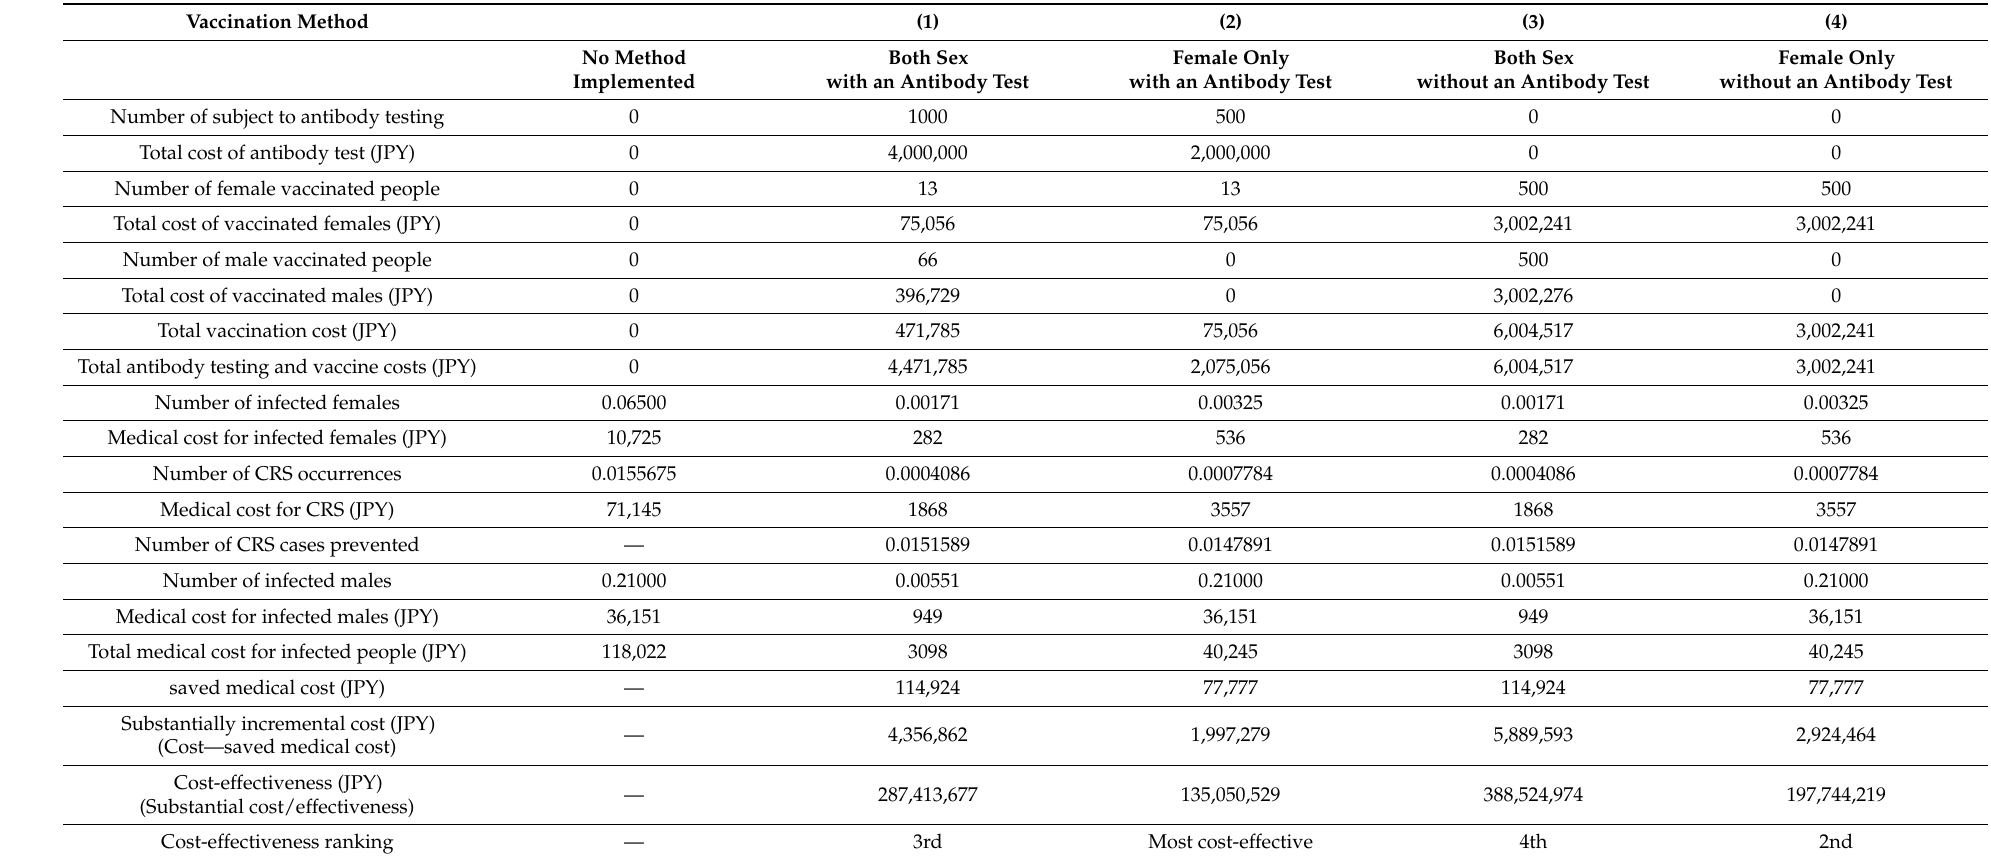
Table 2. Cost effectiveness of the four